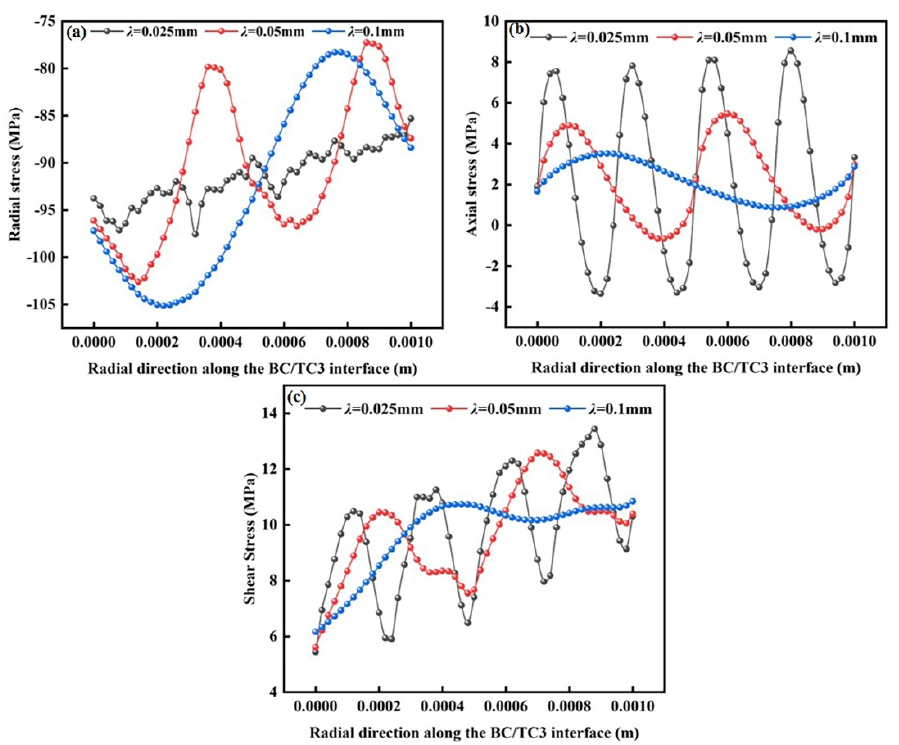
Figure 14. Stress distributions of BC/TC3 interface at different wavelengths: ( a ) radial stress; ( b ) axial stress and ( c ) shear stress.